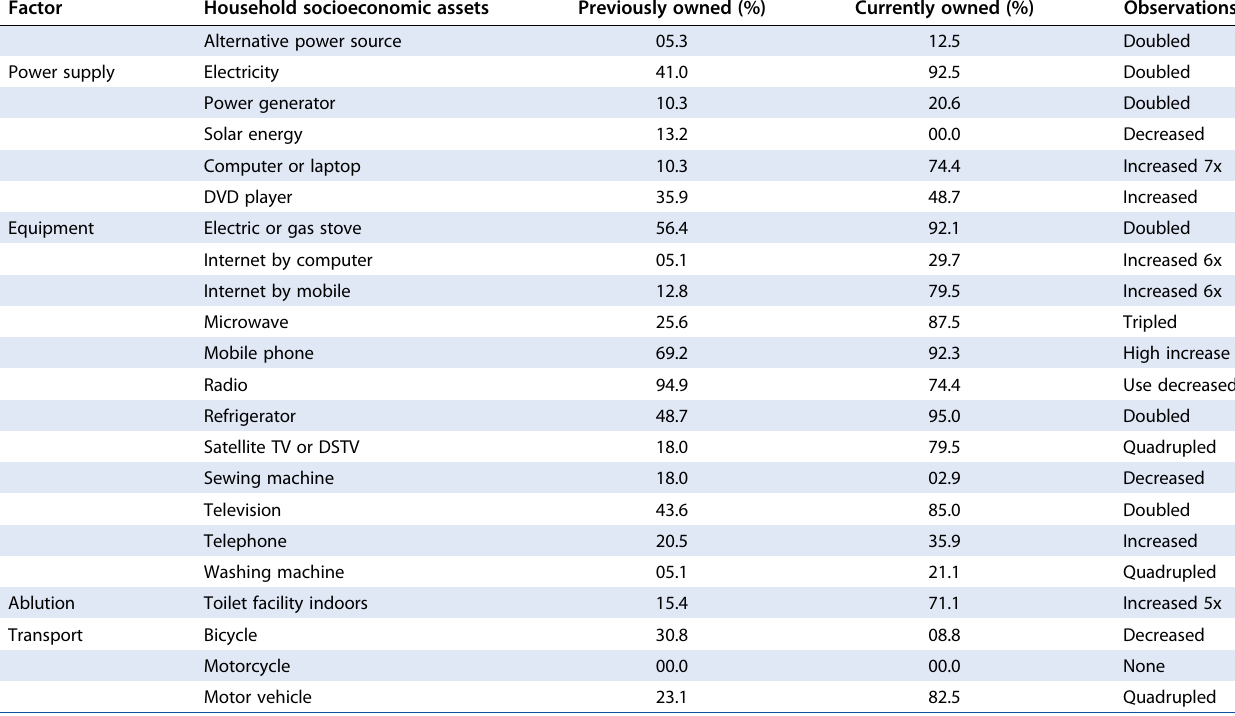
Table 4: Household socioeconomic assets before and while working after graduation Factor Household socioeconomic assets Power